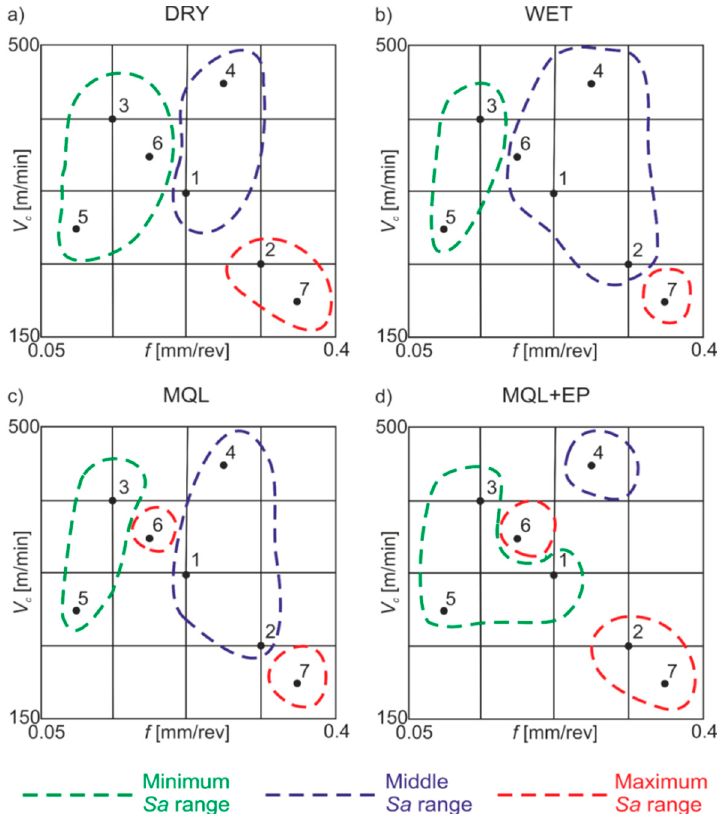
Figure 6. Areas of minimum, medium and maximum Sa values of the surface under: ( a ) dry; ( b ) wet; ( c ) MQL; ( d ) MQL+EP conditions.